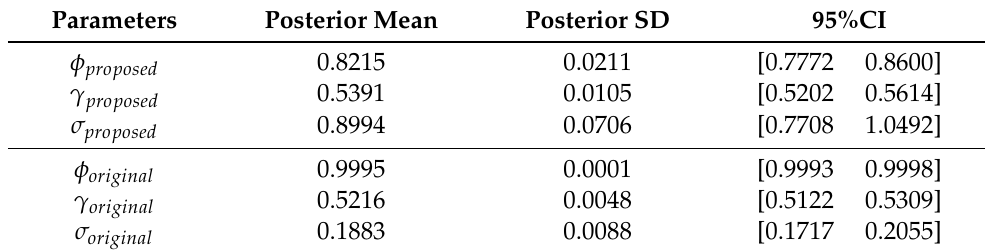
Table 32. Comparison of estimated parameters (4 January 2016, TMC, Aichi, Japan.).